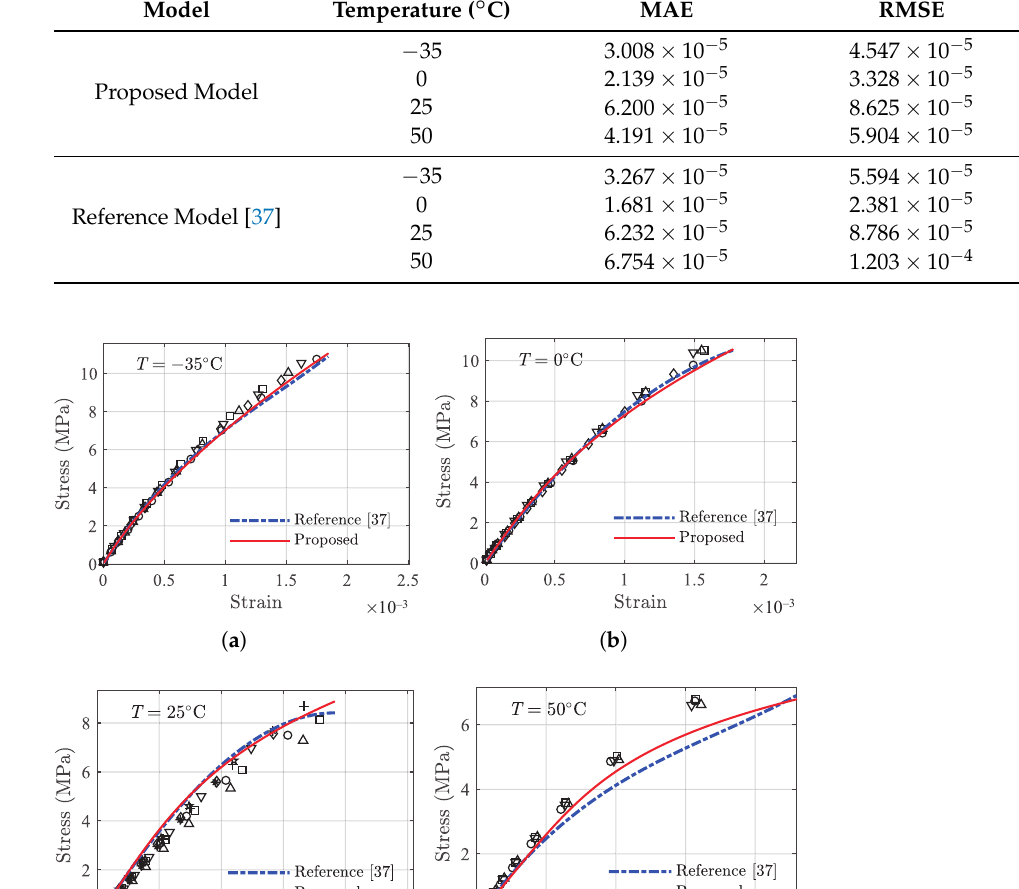
Table 4. Comparisons of the performance between the proposed model and the reference model for tension data.